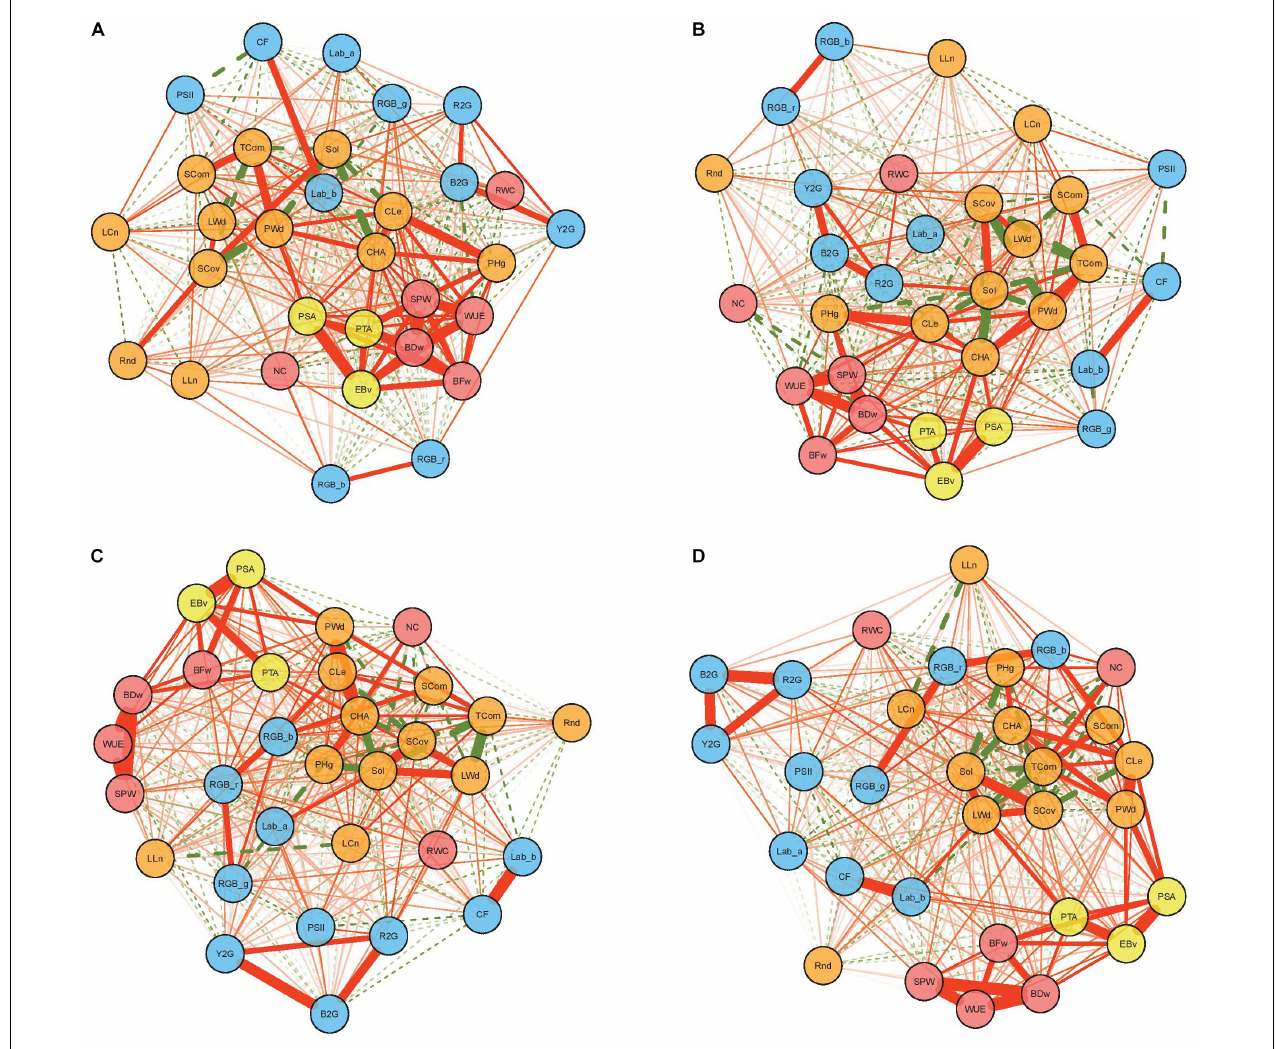
FIGURE 2 | Phenotypic correlation networks among 25 image-based and six manually measured traits in control (A) , nitrogen stress (B) , water stress (C) , and combination of nitrogen and water stress (D) treatment. Full and dotted lines represent positive and negative correlations, respectively. Line width is proportional to the strength of the correlation. Red, yellow, orange, and blue nodes represent manually measured traits, biomass-related traits, architectural traits, and physiological traits, respectively.